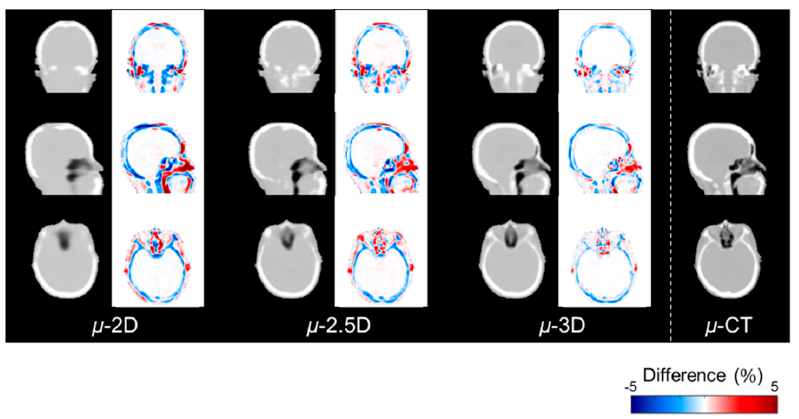
Figure 3. Error in attenuation maps (cm -1 ) relative to the ground truth ( μ -CT). Red color indicates pixel values higher than μ -CT. The 3D convolutional neural network (CNN) resulted in the smallest error in the μ -map.